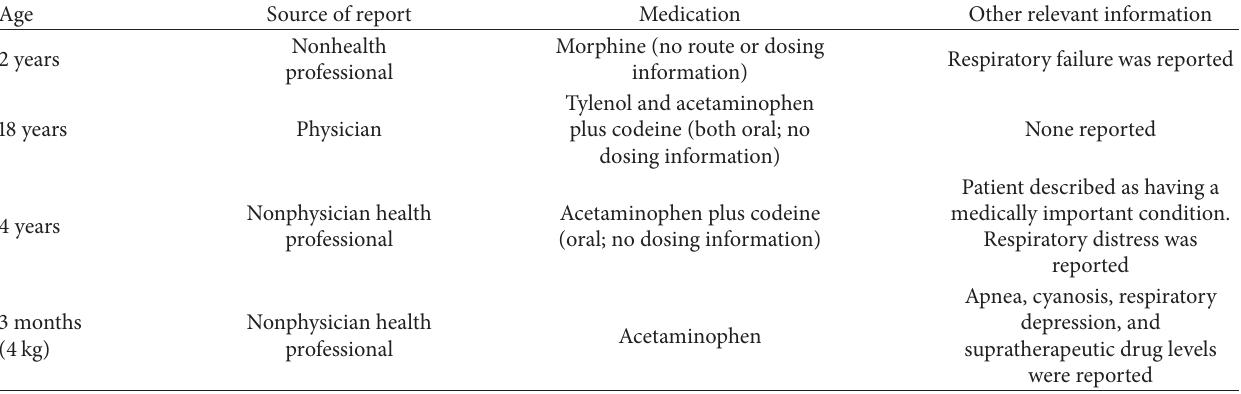
Table 2: Description of deaths reported in Health Canada’s Vigilance Adverse Reaction Online